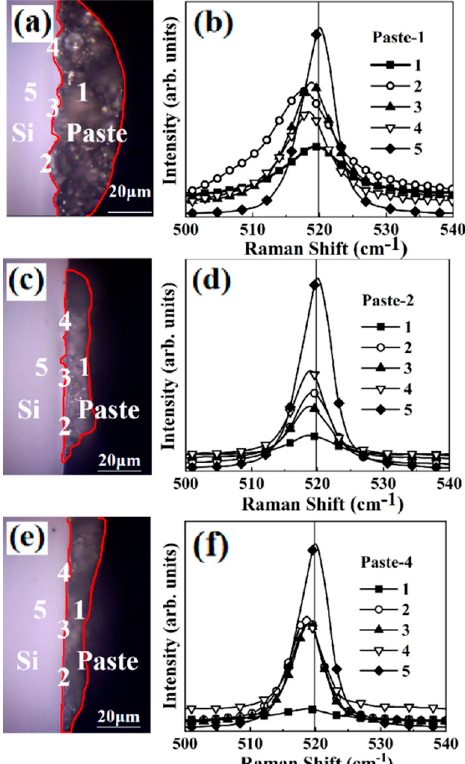
Figure 6. ( a , c , e ) Optical microscope images of Si / paste interfaces with paste 1, 2 and 4; ( b , d , f ) Raman Figure 6. ( a ), ( c ), ( e ) Optical microscope images of Si/paste interfaces with paste 1, 2 and 4; ( b ), ( d ), ( f ) spectra of the Si 1LO detected at di ff erent positions near the Si / paste interface. The detected positions Raman spectra of the Si 1LO detected at different positions near the Si/paste interface. The detected are marked as numeric numbers from 1 to 5 in the optical microscope positions are marked as numeric numbers from 1 to 5 in the optical microscope images.